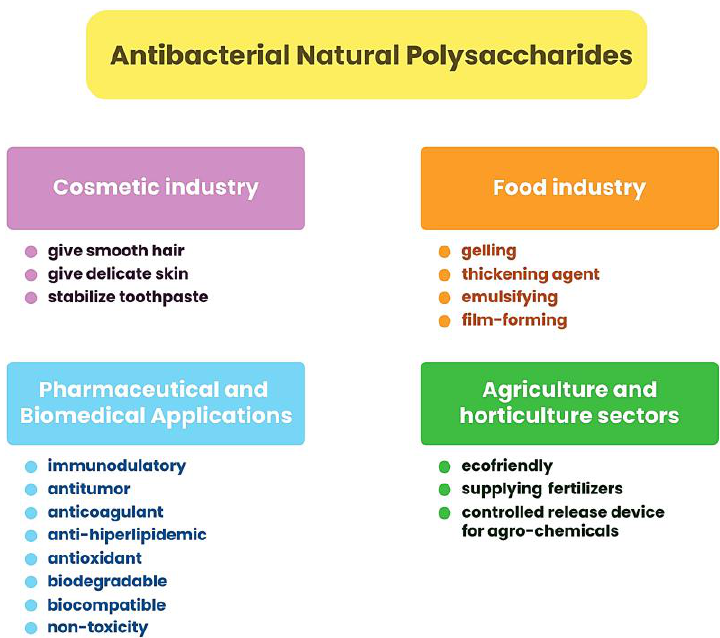
Figure 3. Application of natural antibacterial polysaccharides.